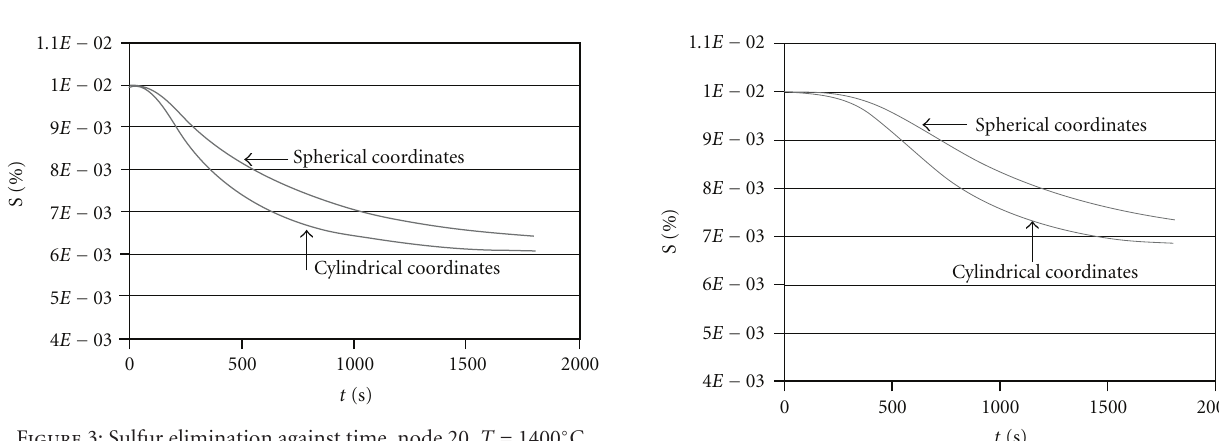
Figure 3: Sulfur elimination against time, node 20, T = 1400 ◦ C.